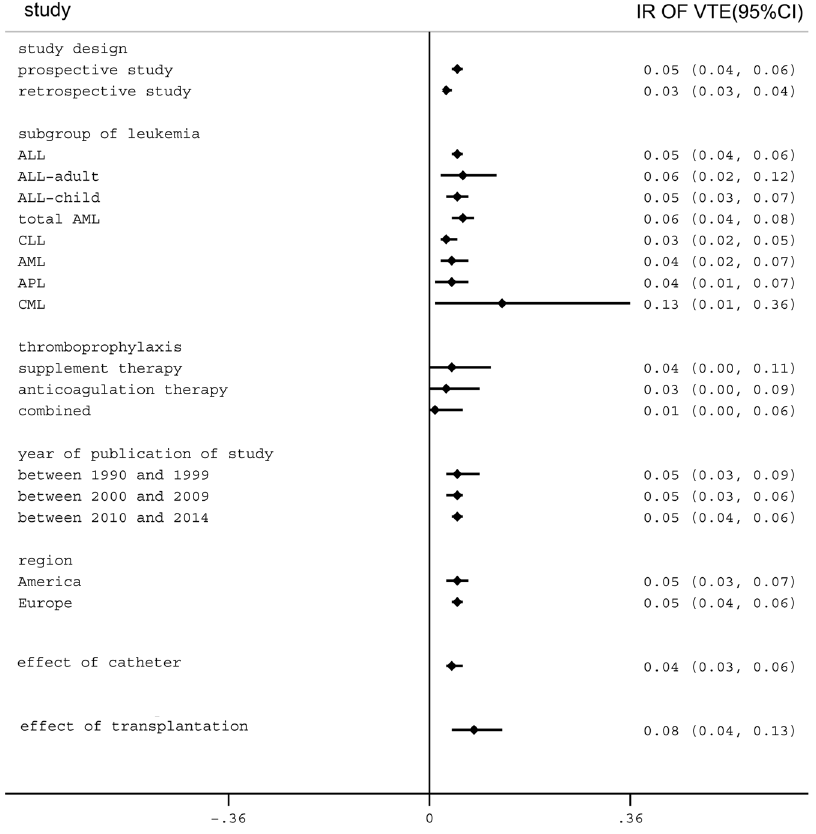
Figure 2. Summary of the categorical meta-analysis. IR = incidence rate. VTE = venous thromboembolism.